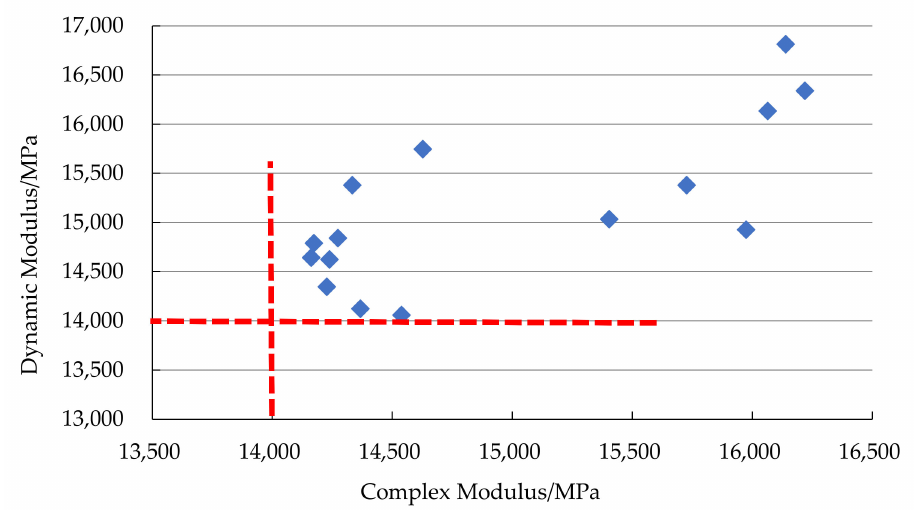
Figure 12. Corresponding relationship of modulus at 20 °C, 10 Hz.